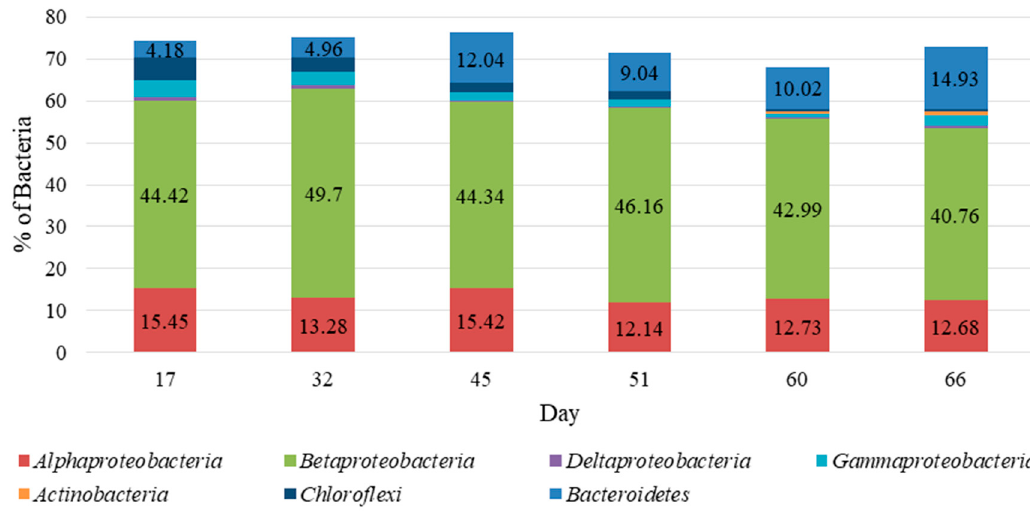
Figure 5. Evolution of bacterial community throughout the SBR operation.